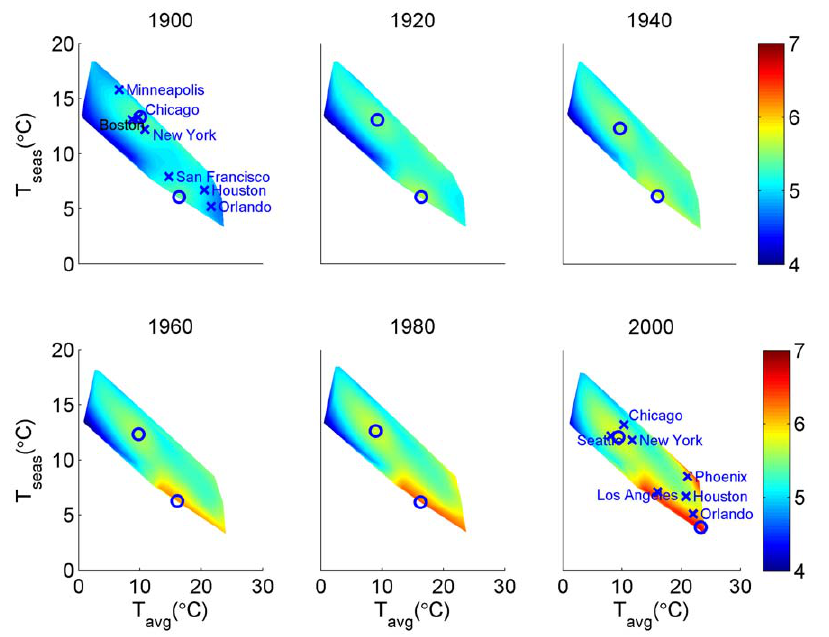
Figure 2. Variation in human abundance across the thermal niche of U.S. populations throughout the 20 th century. The climate niche is based on average annual temperature ( u C) and temperature seasonality ( u C). Human abundance data are from the population census of the year displayed on each panel and the colour ramp is log 10 scaled. The peaks identified with LOESS are shown as circles. We estimated the climate conditions of each temporal horizon by averaging annual climate conditions of the preceding 20 years and, given the lack of climate data prior to 1900, we used the 1901–1920 climate averages in our analyses of both 1900 and 1920. See Fig. S4 for a similar analysis based on precipitation.